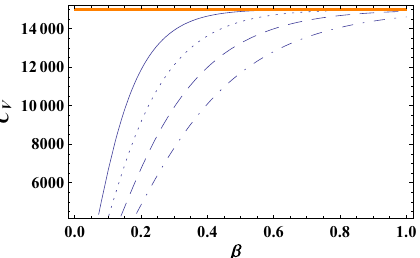
Fig. 2 Behavior of the specific heat of an ideal gas C V versus β for both the classical and deformed theory. The colored thick curve repre- sents the result of the classical theory while other curves correspond to results in the presence of natural cutoffs for different values of α = 0 . 1 , 0 . 12 , 0 . 14 , 0 . 16, from solid to the dashed-dot curve respec-